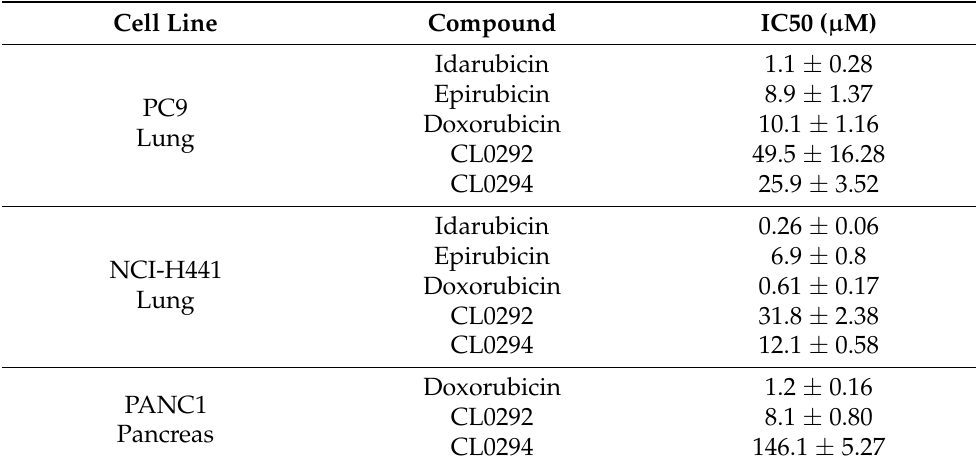
Figure 3. Inhibition of growth of cultured cancer cell lines. The indicated cell lines were exposed to increasing concentrations of Doxorubicin (used as positive control of inhibition), Idarubicin, Epirubicin, CL0292 and CL0294 for 48 h and cell survival was assessed using AlamarBlue ® assays as described in Materials and Methods. Results are expressed as percentage of cell growth compared to untreated cells. Table 2. IC50 values for anthraquinone compounds inhibiting the growth of lung and pancreatic cancer cell